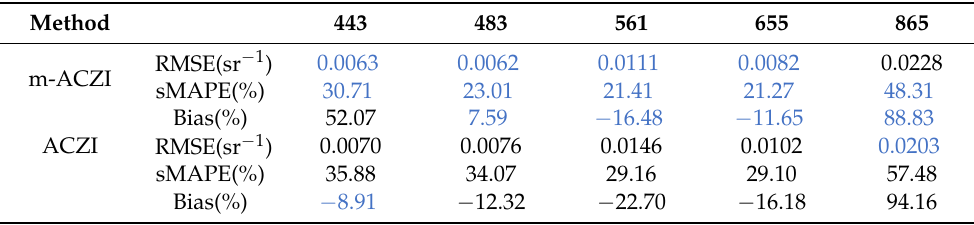
Table 1. Statistics of the accuracy measures for the ACZI and the m-ACZI algorithms using in situ R rs measurements. The BLUE number represents the minimal statistical